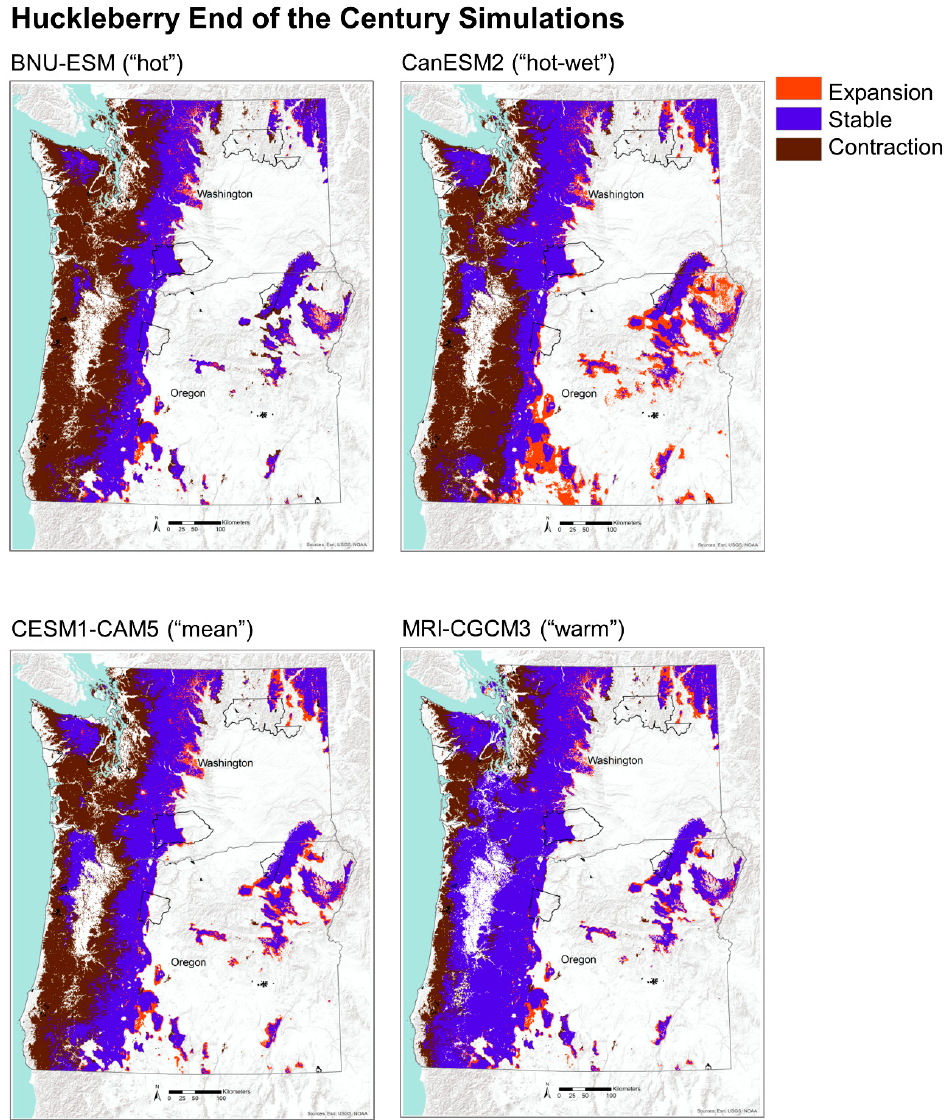
Figure A2. Projected potential suitable habitat for huckleberry and bitterbrush based on four GCM simulations for mid and end of century under RCP 8.5. Tribal reservations are delineated with black polygons.